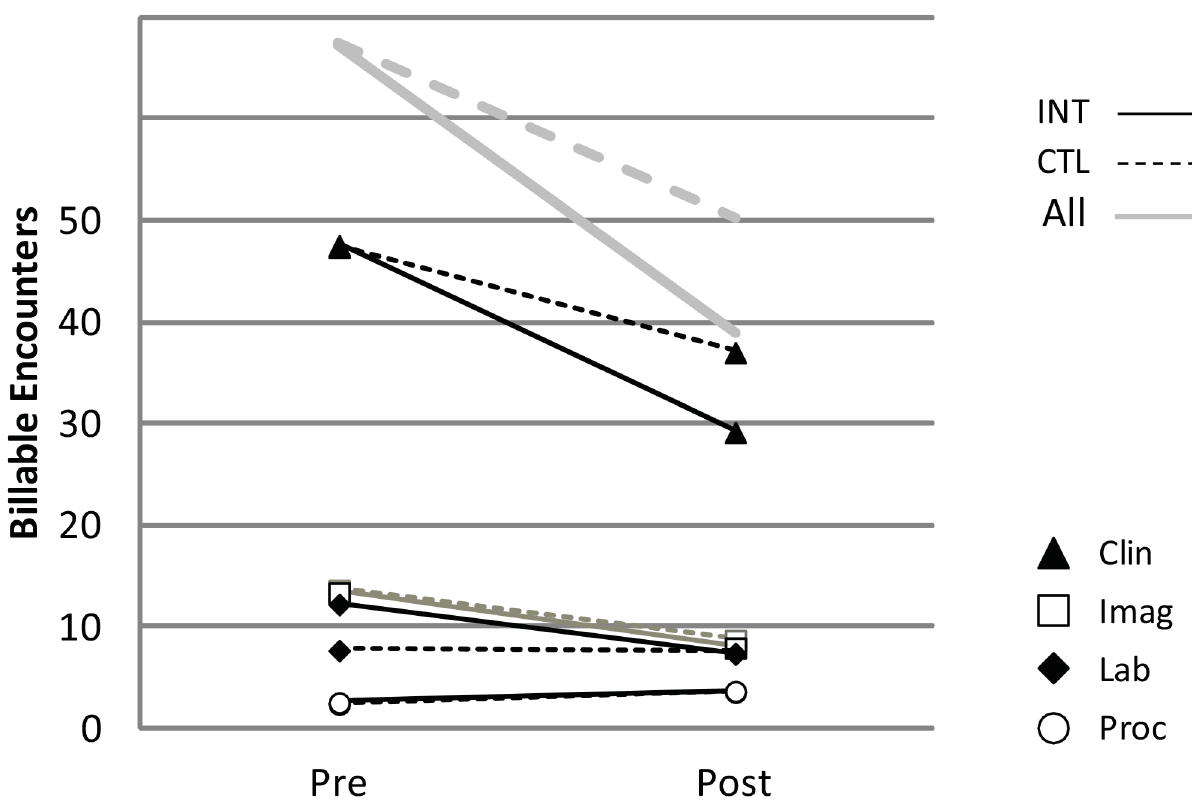
Fig 2. Utilization by Functional class: high utilizing controls vs. propensity score, initial utilization rate matched intervention group. INT = Intervention, CTL = Control, Clin = Clinical, Imag = Imaging, Lab = Laboratory, Proc = Procedure.